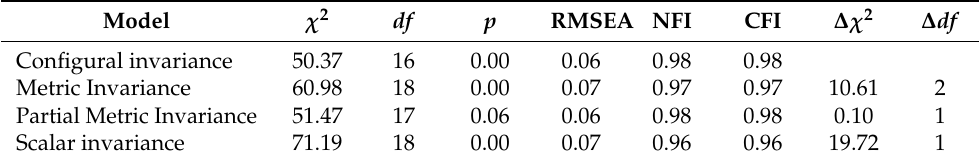
Table 7. Fit indices for the nested sequence of models in multigroup